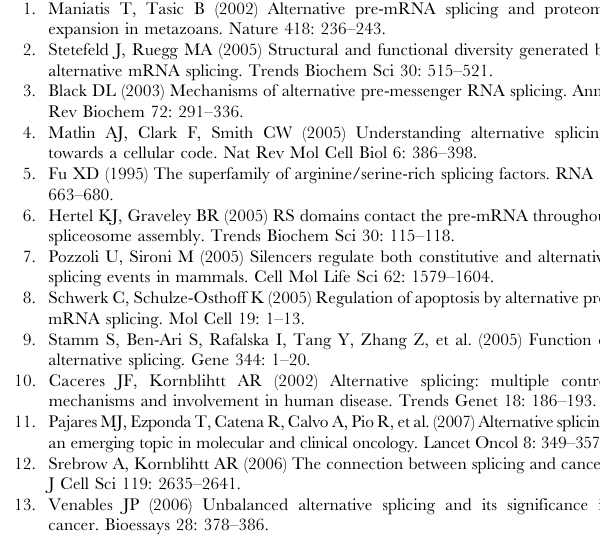
Table S2 The significant GO terms of genes with alternative RNA splicing altered in amiloride-treated Huh-7 cells. Table S3 The splicing factor-binding exonic and intro- nic elements of genes showing altered alternative RNA splicing in amiloride-treated Huh-7